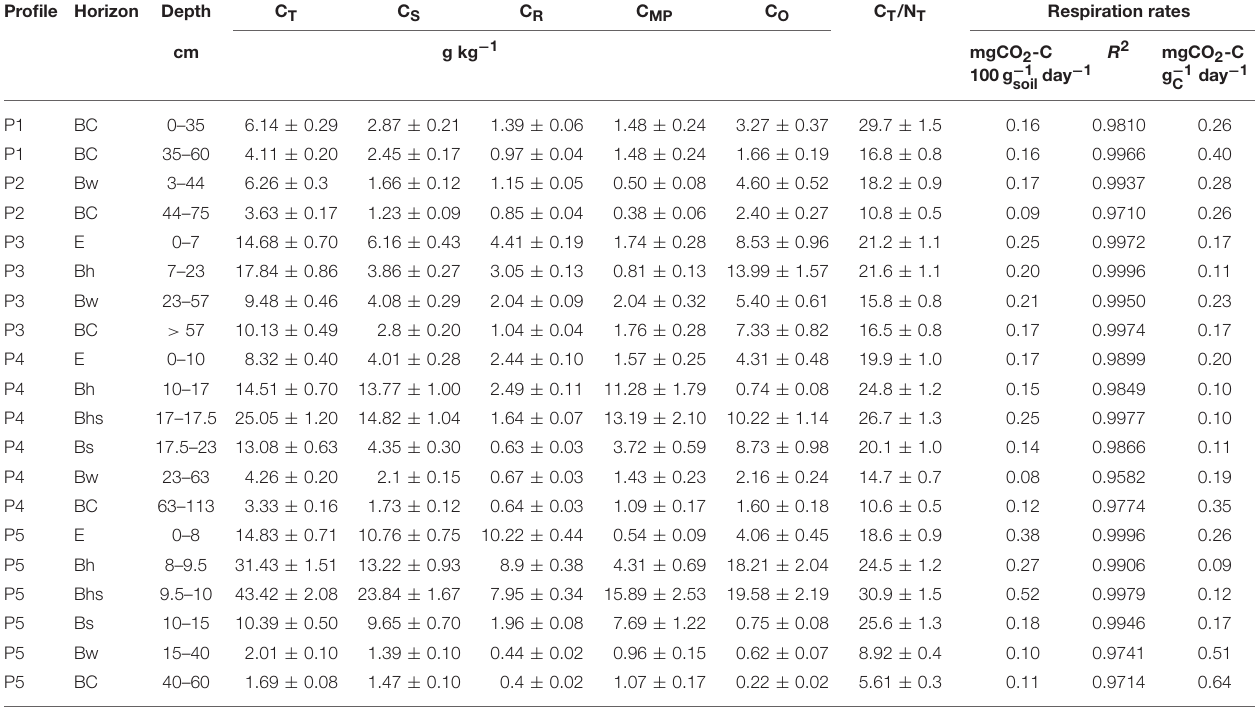
TABLE 2 | C fractions: total (C T ), Stable (C S ), recalcitrant (C R ), mineral-protected (C MP ), oxidizable (C O ), bulk soil SOM C T /N T ratio (values are given ± one standard deviation); soil respiration rates (slope of the cumulative CO 2 emission with time, calculated by linear regression, and associated R ² -values), and soil respiration rates normalized by the total SOC content ( = SOM